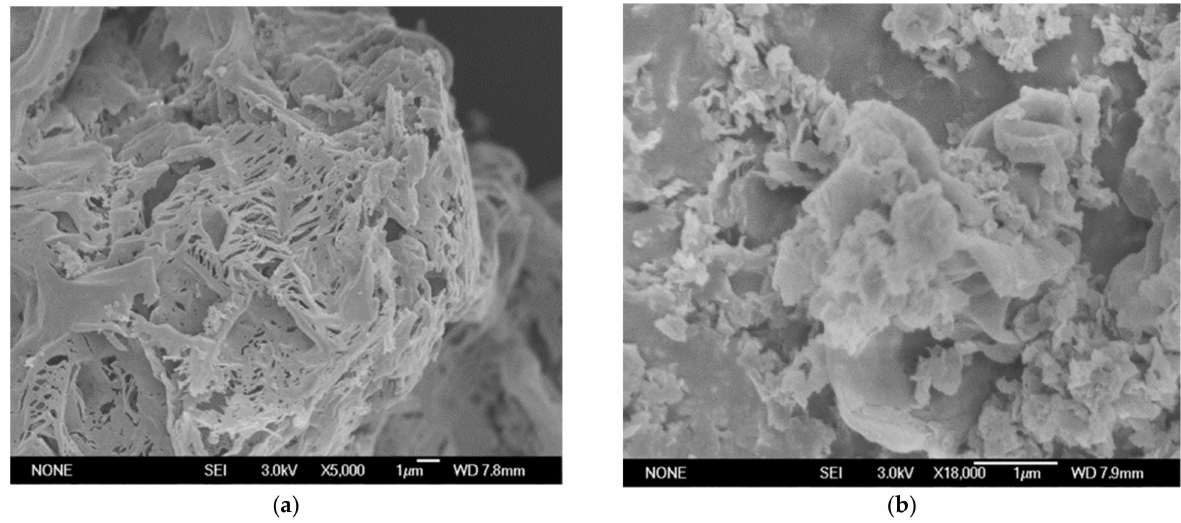
Figure 6. SEM images of ( a ) CN; ( b ) CN-6.